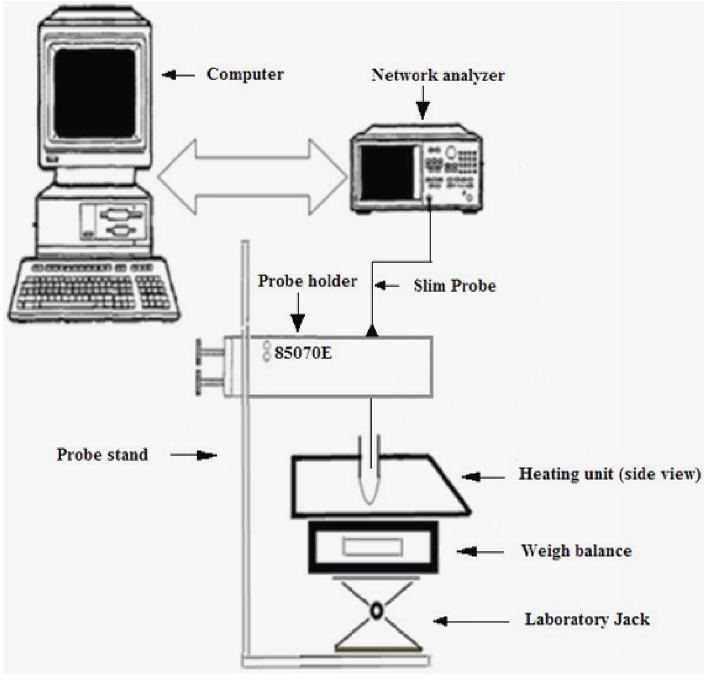
Figure 1. Schematic of the experimental setup for measurement of dielectric properties of methanol fractions (Source: Adapted from